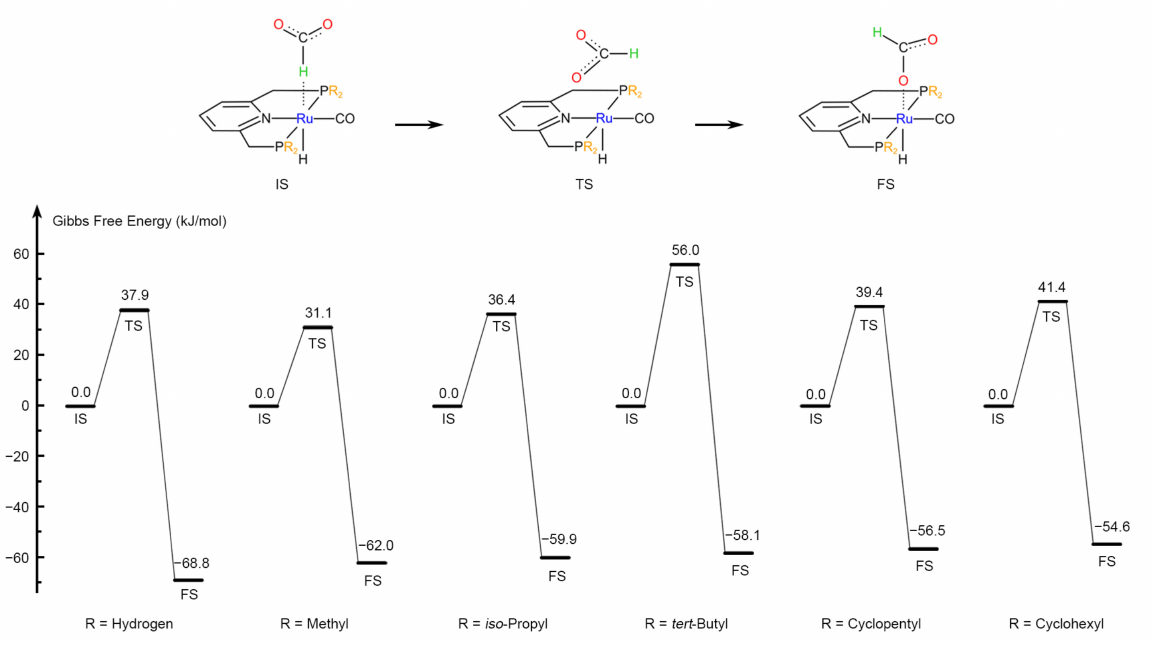
Figure 4. Free energy profile for HCOO − rotation on six Ru-PNP complexes with different